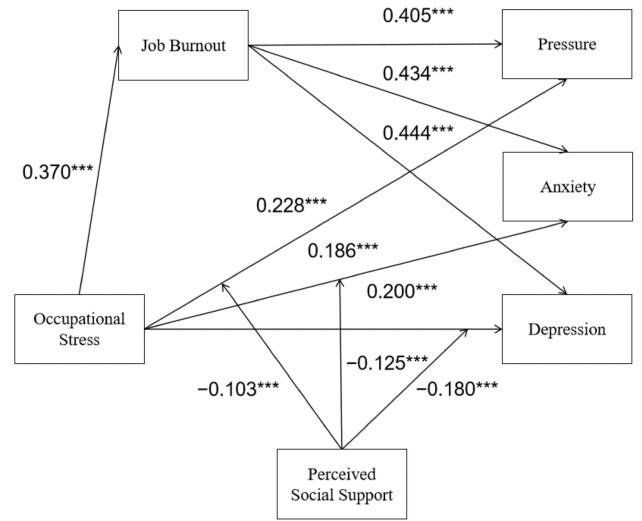
Figure 2. Moderated mediation model of job burnout and perceived social support in the association between occupational stress and mental health. *** p < 0.001.